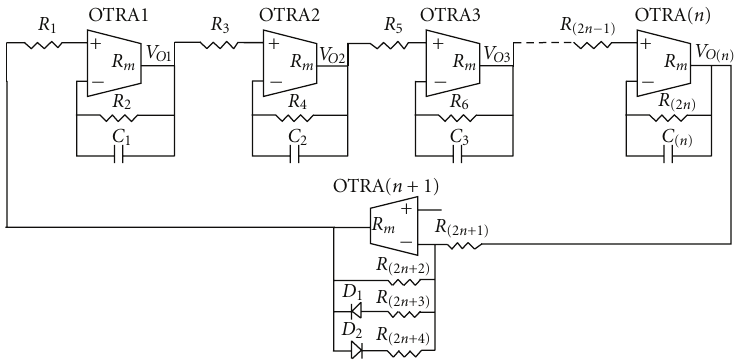
Figure 3: Generalized scheme for producing n odd- or even- phase oscillations with